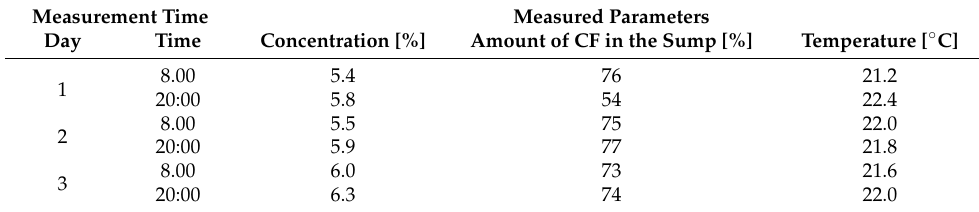
Table 1. An example of possibilities of results of a testing run of the